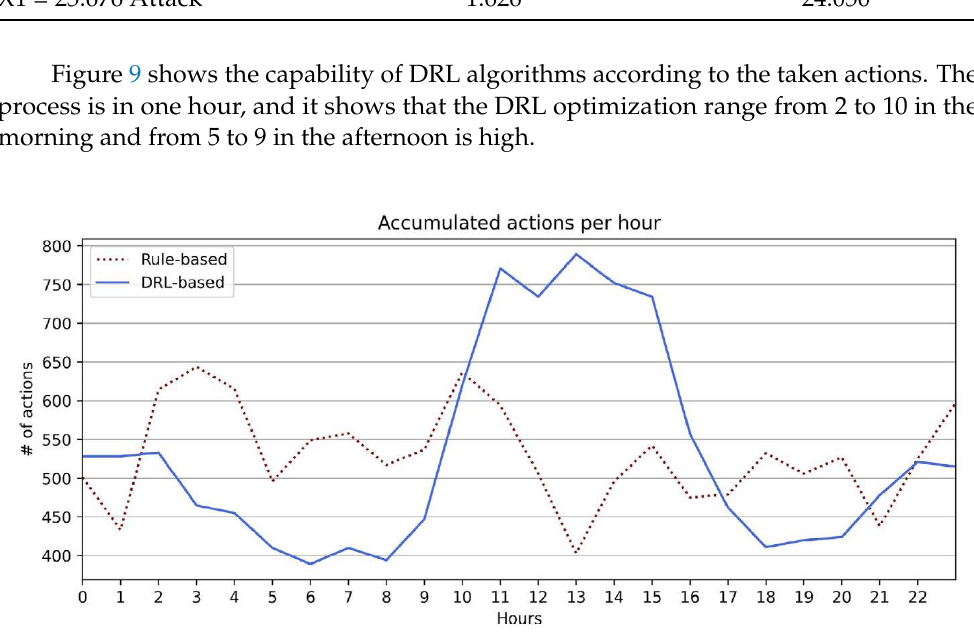
Figure 9. DRL action distribution in smart home architecture.